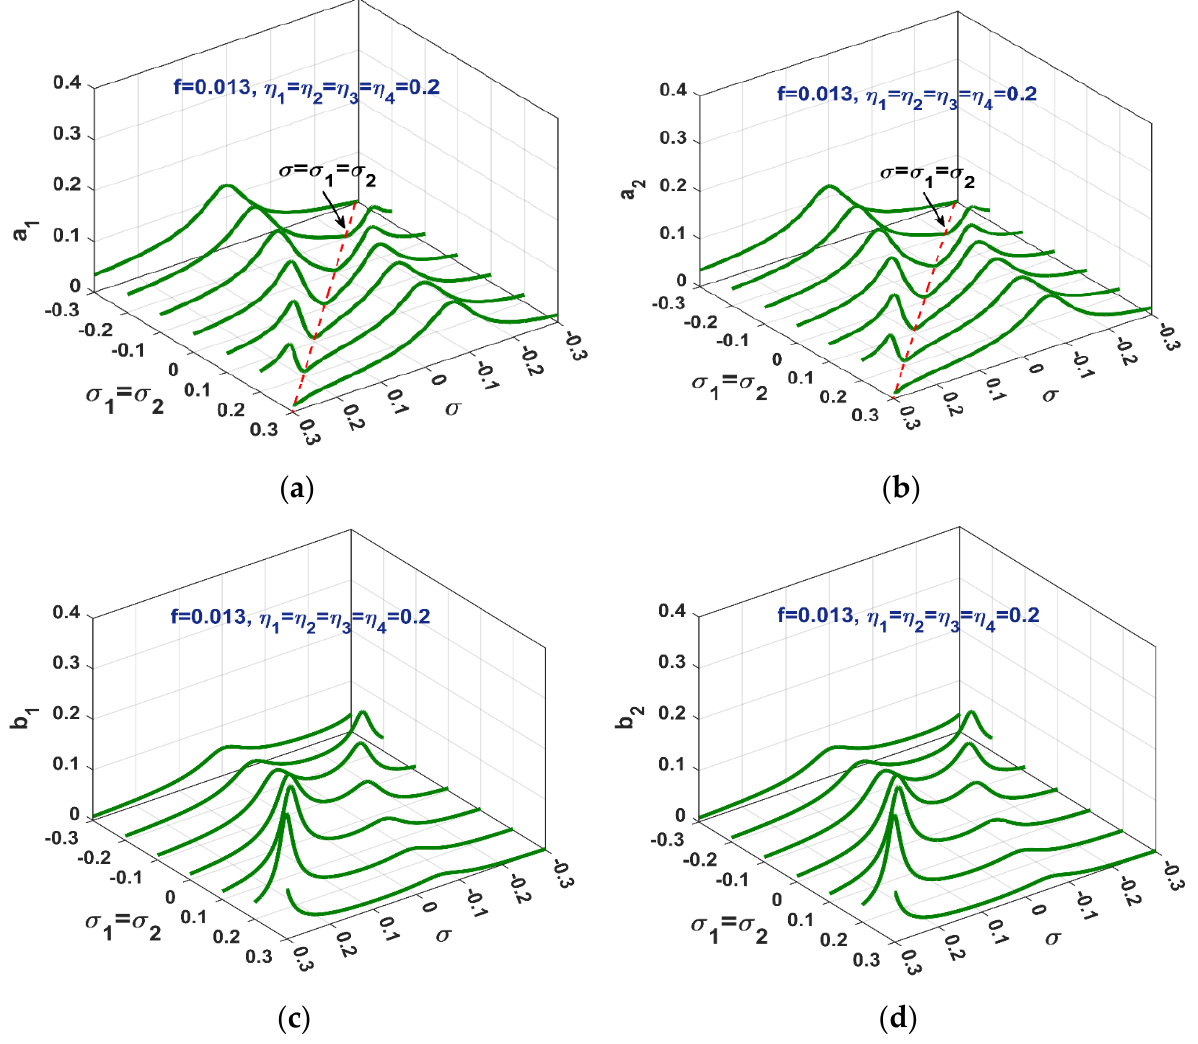
Figure 10. Vibration amplitudes of the twelve-poles s rotor in the case of the 𝑃𝐷 + 𝐼𝑅𝐶 + 𝑃𝑃𝐹 -con- trol algorithm at 𝑓 = 0.013, and 𝜂 rotor, and ( c , d ) vibration amplitudes ( 𝑏